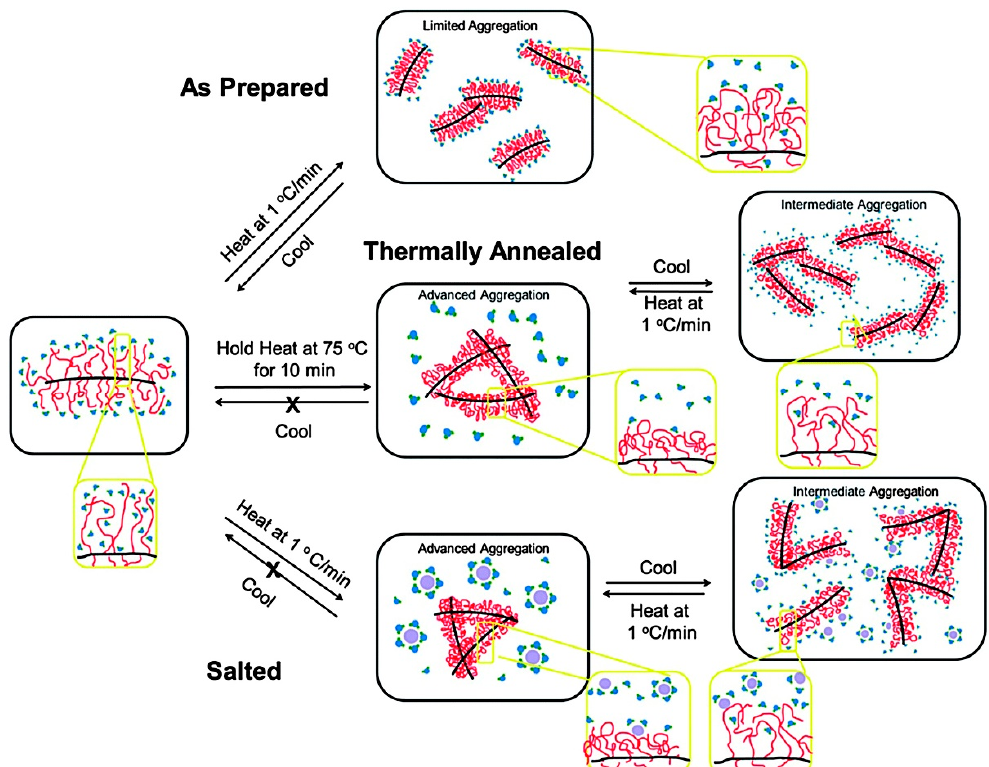
Figure 4. A schematic description showing the proposed polymer conformation and the level of aggregation in as-prepared or thermally annealed salt-free solutions or as-prepared salted solutions of the polypeptoid bottlebrushes. Reprinted with permission from [72] . Copyright 2014, Royal Society of Chemistry.